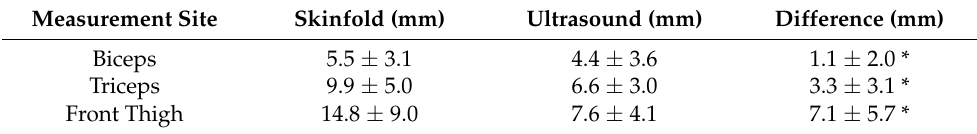
Table 1. Mean ( ± standard deviation) measures at each site and the difference between the